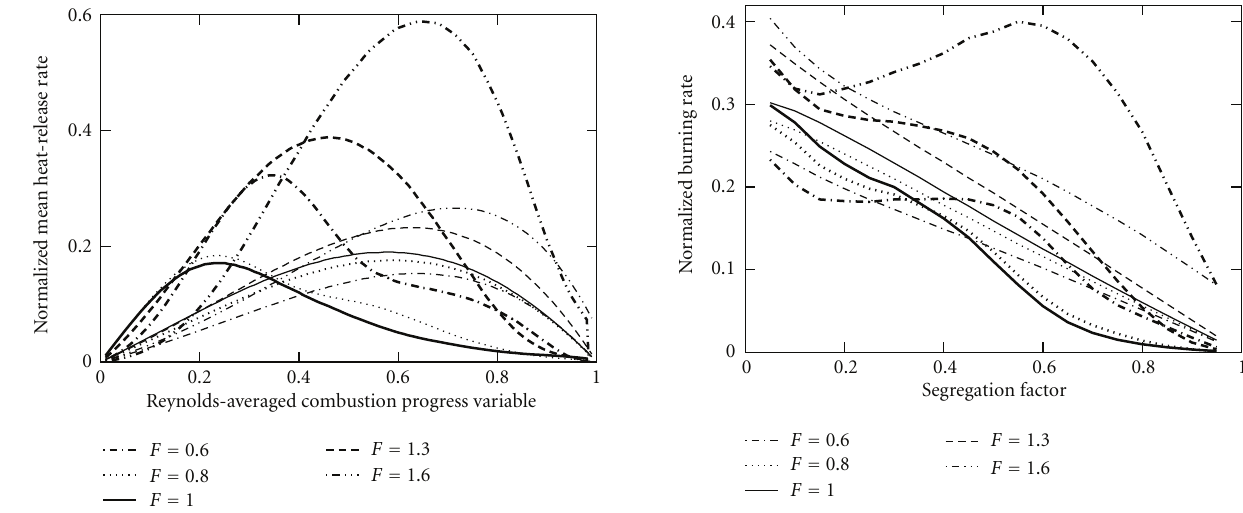
Figure 8: Dependencies of the normalized burning rate integral u t on the segregation factor c (cid:3) 2 / [ c (1 − c )], calculated for various equivalence ratios specified in legends using the beta-function PDF (thin curves) and the 2 δ -PDF (bold